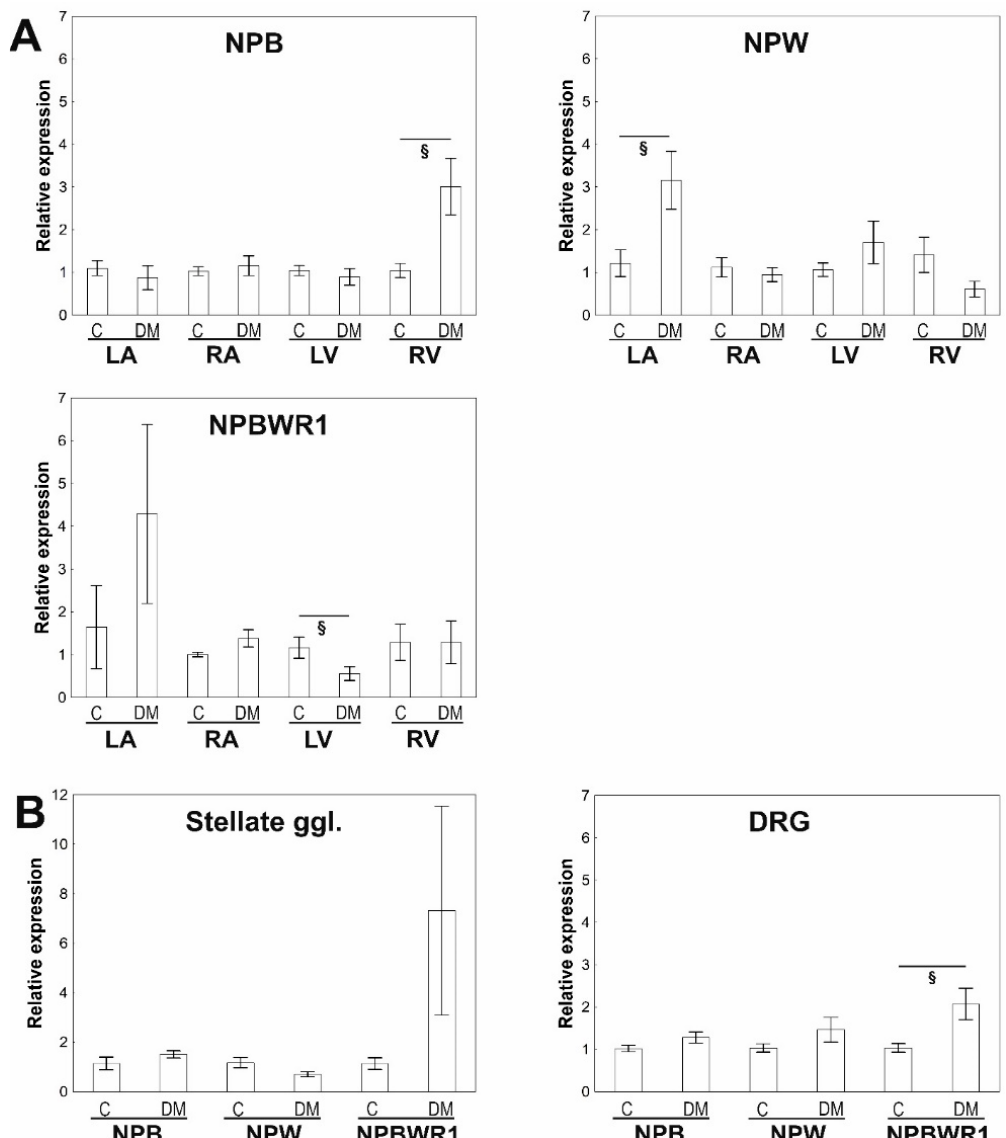
Figure 1. Quantitative RT-PCR analyses of NPB, NPW, and NPBWR1 mRNAs in separate heart compartments, dorsal root ganglia (DRG), and stellate ganglia of the control rats and Zucker diabetic fatty (ZDF) rats with type 2 diabetes mellitus. ( A )—Comparison of expression of studied genes between the control and diabetic animals within separate heart compartments: left atrium (LA), right atrium (RA), left ventricle (LV), and right ventricle (RV). Data are presented as relative expression ± SEM. Control values of the appropriate heart compartments were used as comparators and were settled as 1. Statistically significant differences between the heart compartments are shown graphically. n = 5–8 in each group. ( B )—Comparison of expression of studied genes between control and diabetic animals within dorsal root ganglia (DRG) and stellate ganglia. Statistically significant differences are shown graphically. n = 5–8 in each group. § p < 0.005 (Mann–Whitney test).